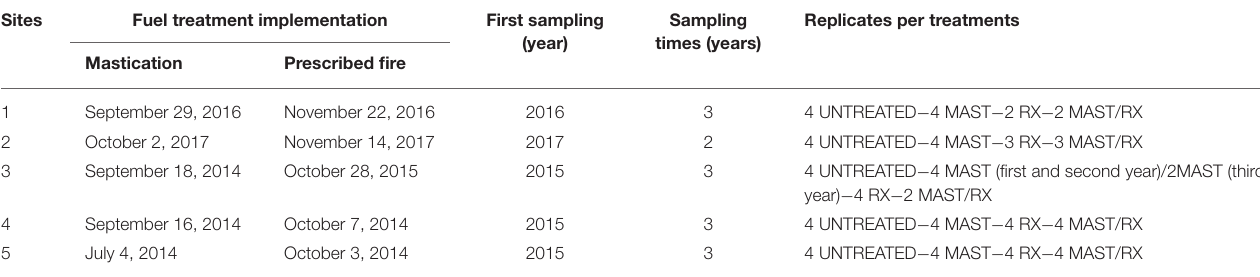
FIGURE 3 | Images of fuel treatments: residues on the floor (UNTREATED) (A) , mastication (MAST) (B) , prescribed fire (RX) (C) , and mastication plus prescribed fire (MAST/RX) (D) . TABLE 2 | Details of fuel treatment implementation, vegetation samplings, and replicates per treatments at each study site.